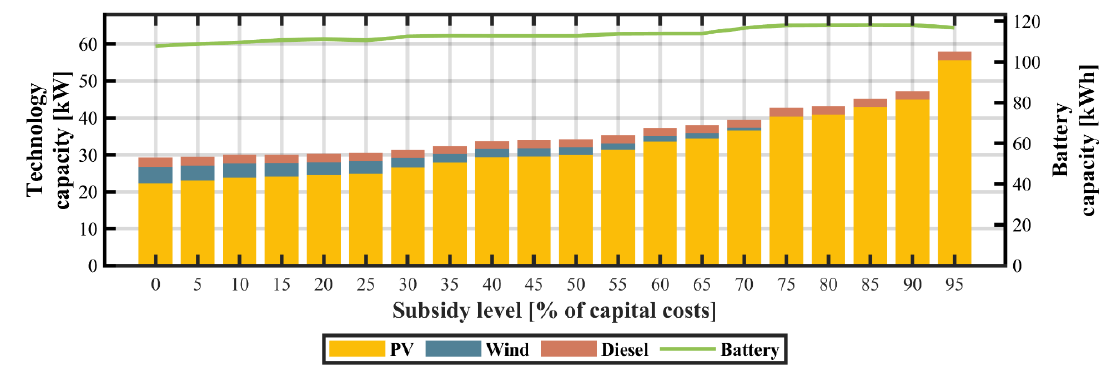
Figure 11. Simulation results of capital subsidies for PV technologies. Impact on the capacity of DG technologies.